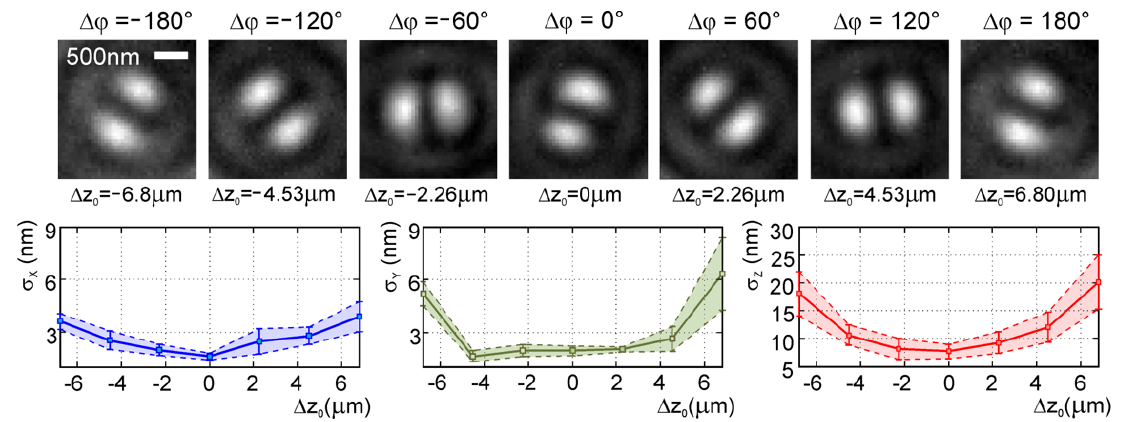
Figure 18. Localization of 100 nm gold beads by the vortex FINCH microscope: DH PSF and standard deviations for x, y, z coordinates evaluated at seven different depths in the axial range of 13.6 µm.